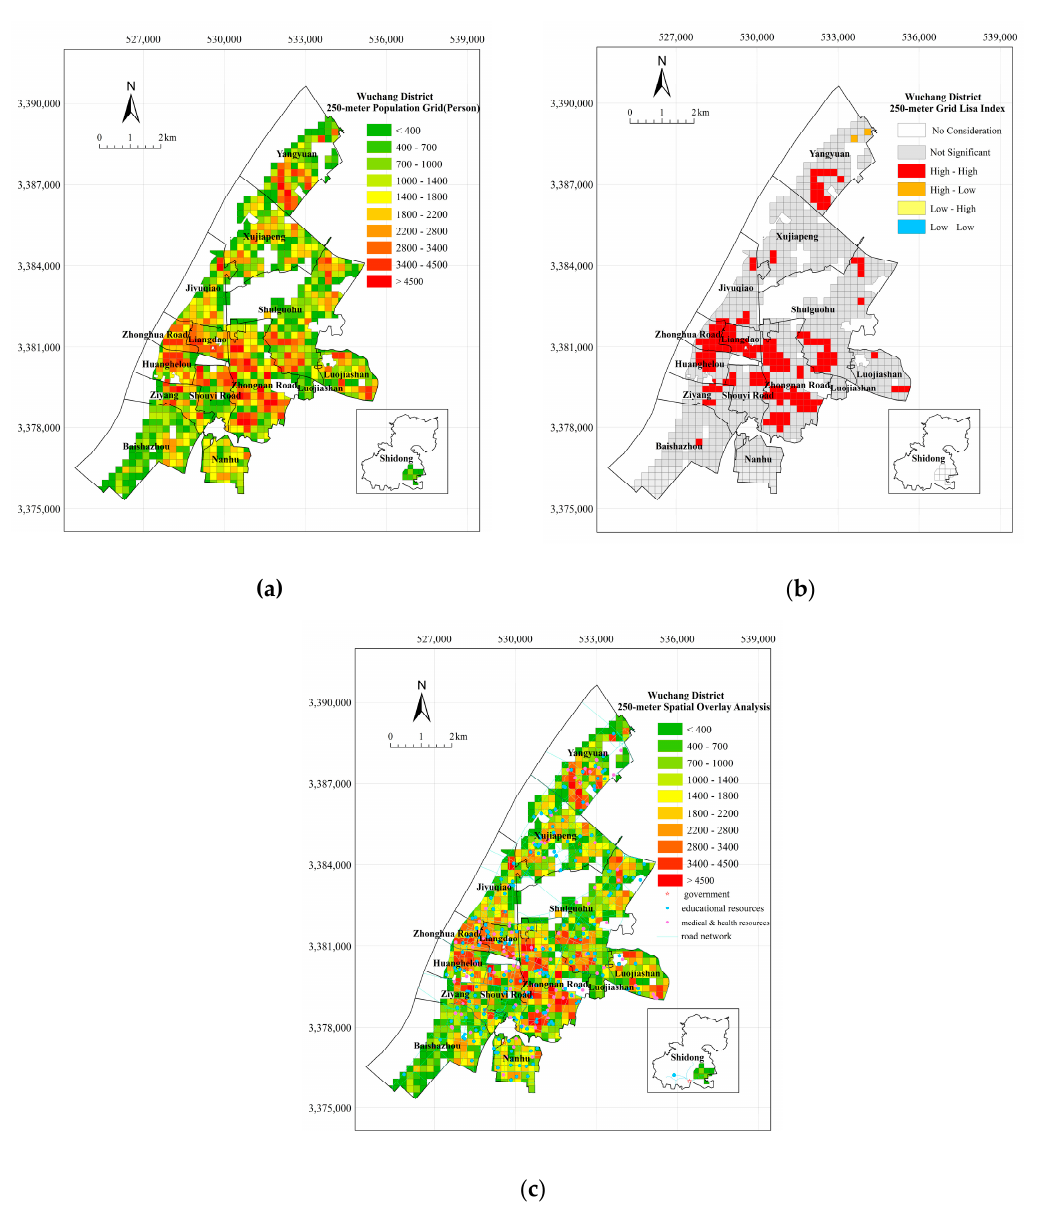
Figure 8. The Experimental Results and Analysis on the District Level (( a ) Wuchang 250-m Population Grid; ( b ) The Result of Local Moran’s I;and, ( c ) Spatial Overlay Analysis).